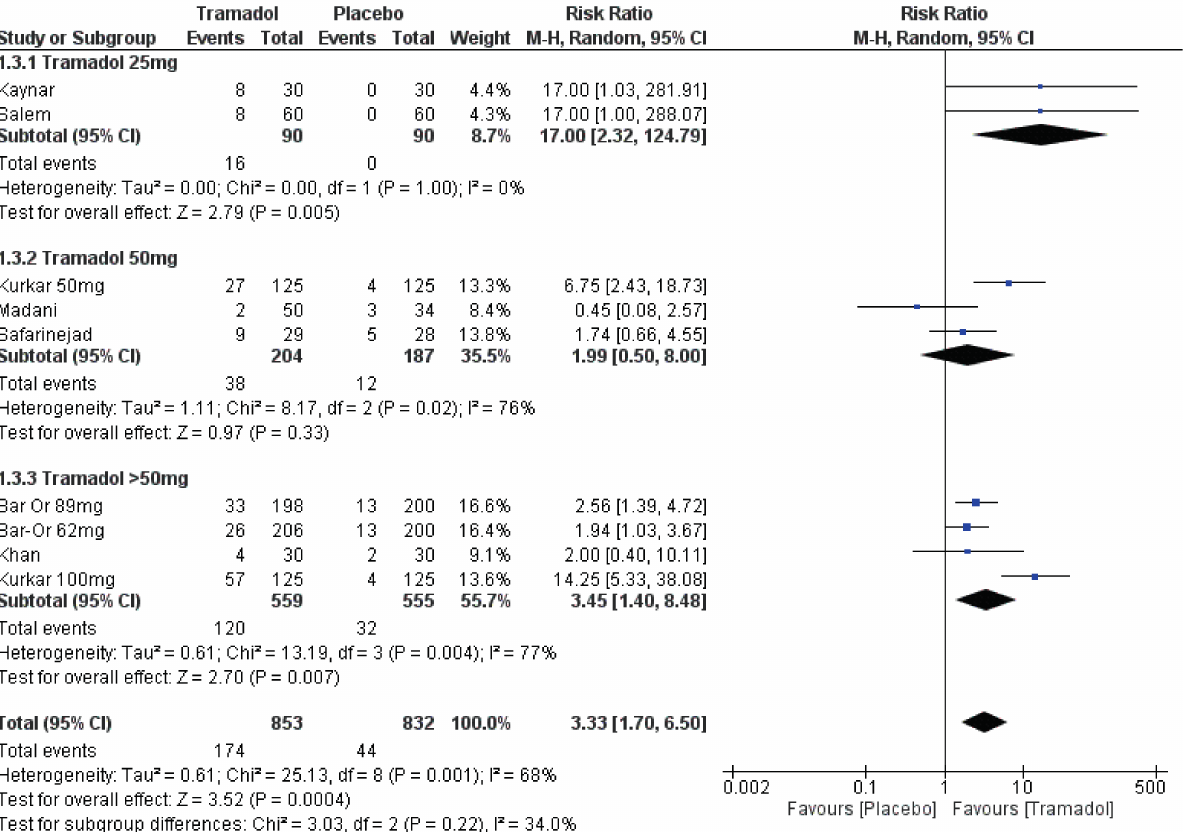
Figure 6 - Forest plot depicting comparison of side effects of Tramadol to placebo at various doses.